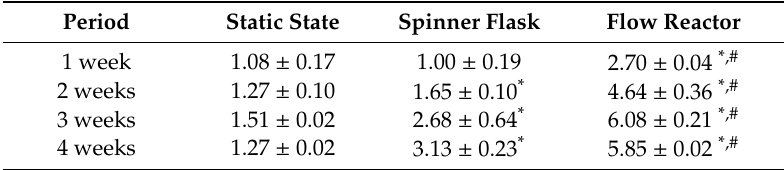
Table 1. The hMSCs’ expansion rate in different culture systems.